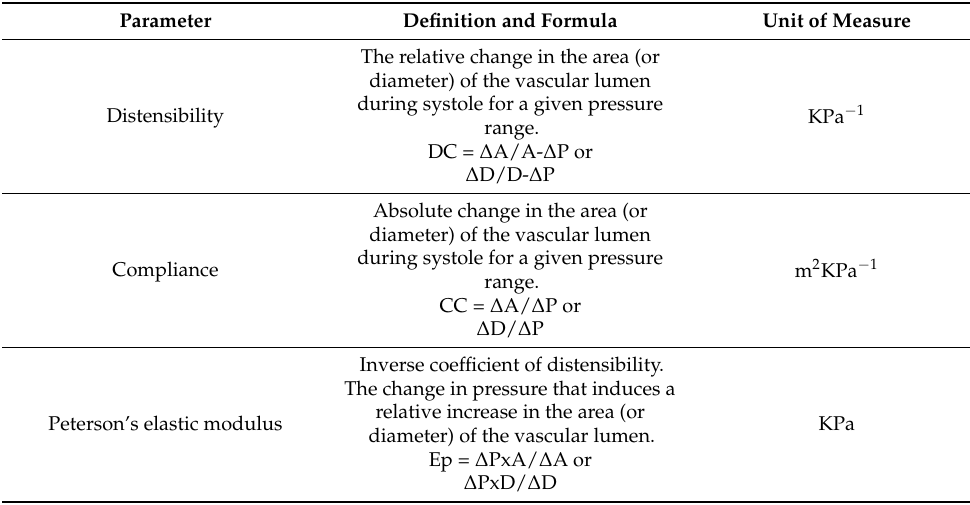
Table 3. Measures of arterial elasticity by using